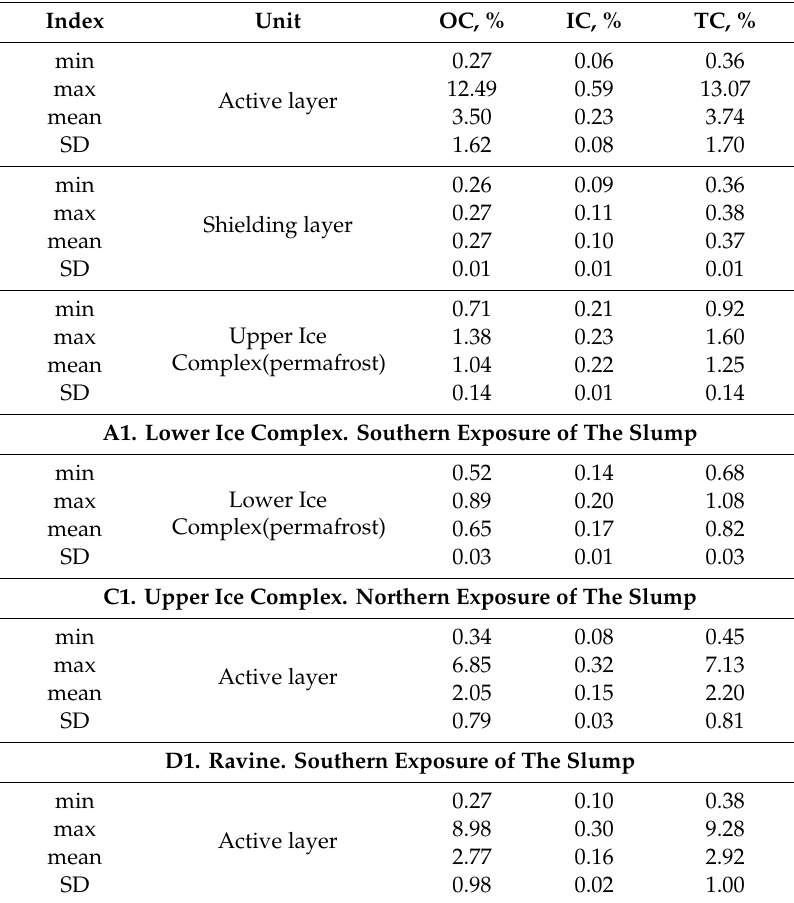
Table 2. The carbon content in the cover deposits of the upper and lower Ice Complex units.